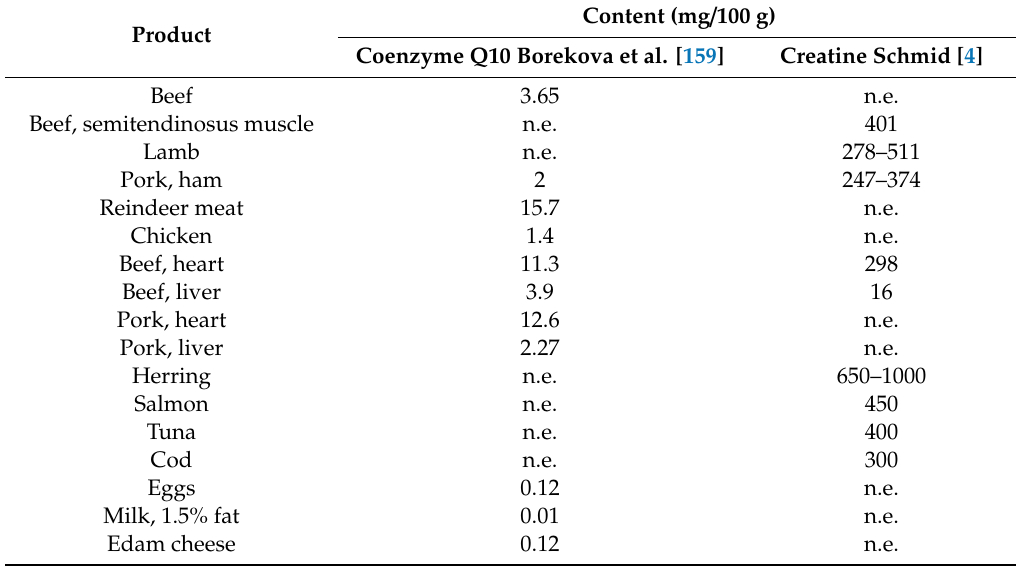
Table 7. Contents of coenzyme Q10 and creatine in meat and animal origin